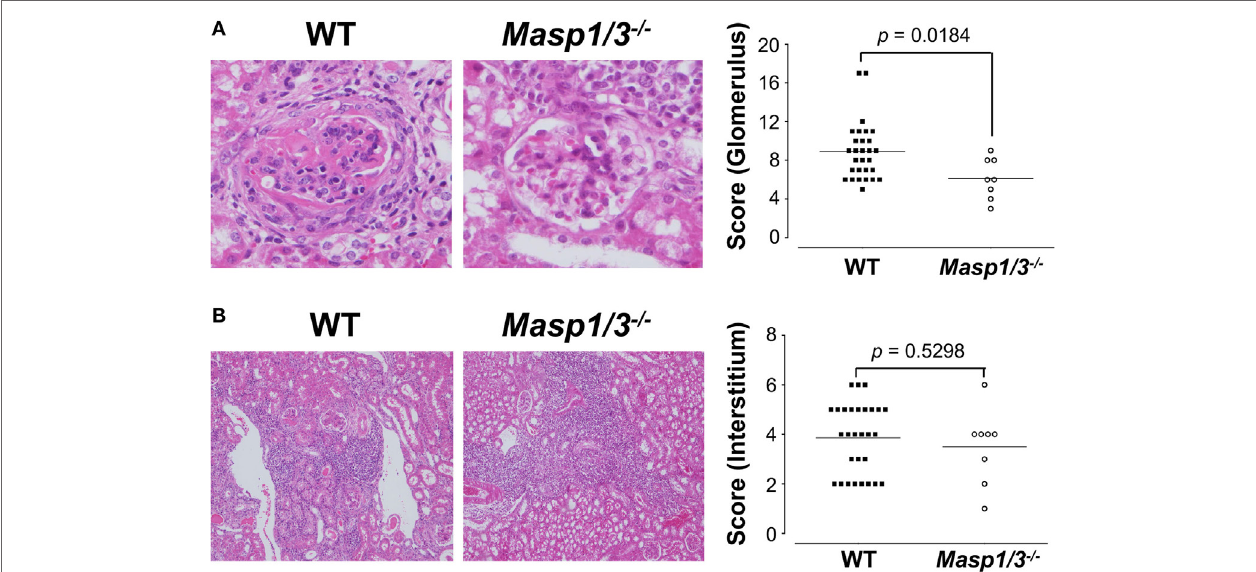
FigUre 6 | Assessment of glomerular (a) and renal interstitial (B) pathologies stained with hematoxylin and eosin. Glomerular pathology was graded from the sum of scores for glomerular inflammation, thickness of basement membrane, epithelial cell reactivity, crescent formation, and necrosis. Interstitial pathology was graded using the sum of scores for perivascular inflammation and inflammatory cell infiltration. Scores were graded as 0 to 4 + (0, none; 1 + , mild; 2 + , moderate; 3 + , moderate-high; 4 + , high). Original magnification 200 × for glomerular pathology, and 40 × for interstitial pathology.